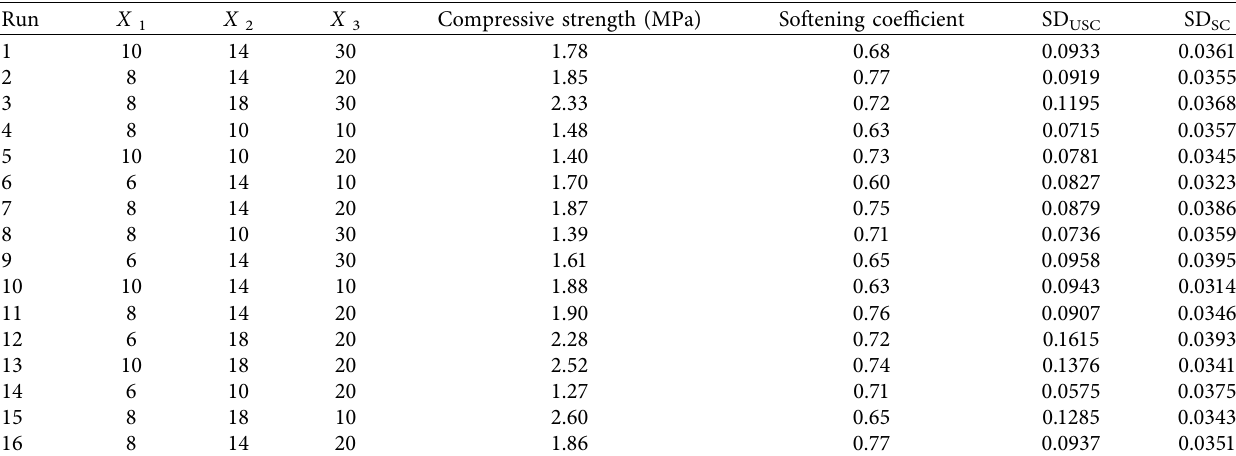
Table 6: BBD experimental design variables and results of unconfned compressive strength and softening coefcient tests. Run